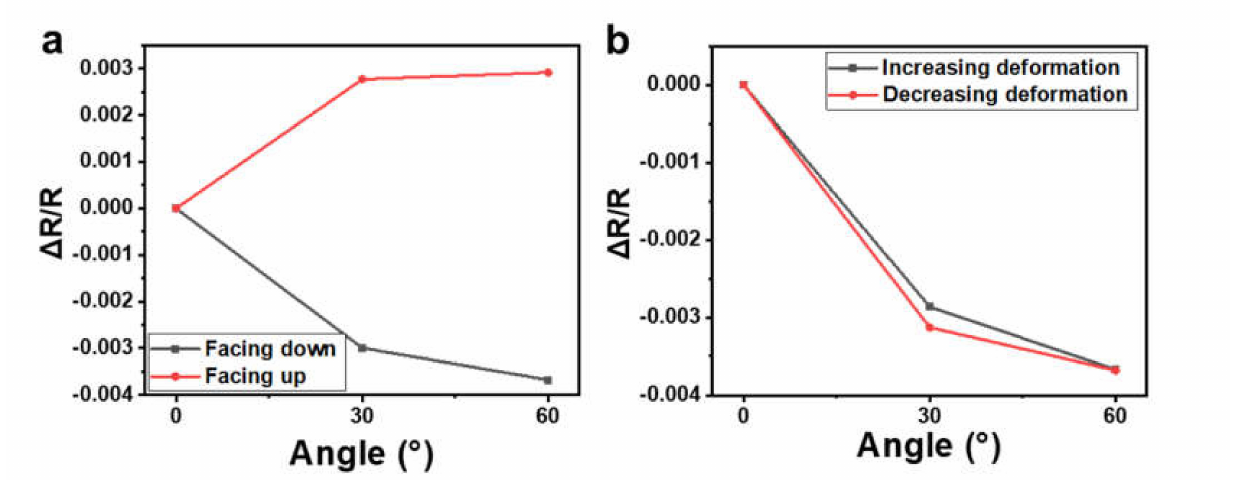
Figure 7. ( a ) Relative resistance changes in response to angles when the sensor was tested facing down and facing up. ( b ) Relative resistance changes in response to the angles of the sensor tested facing down while the bending angles were increased and decreased.